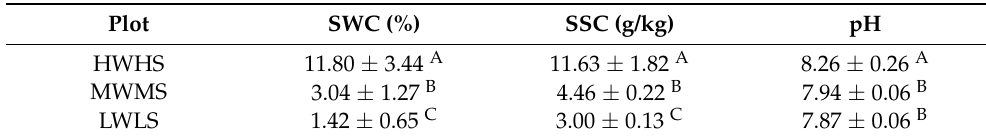
Table 2. The soil environmental factors in three plots.